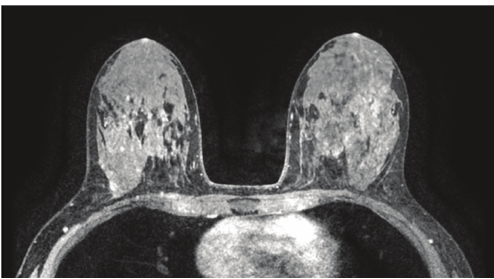
Figure 1: MIP image from breast MRI showing multiple regions of enhancement with no mass in the area of clinical concern left breast.